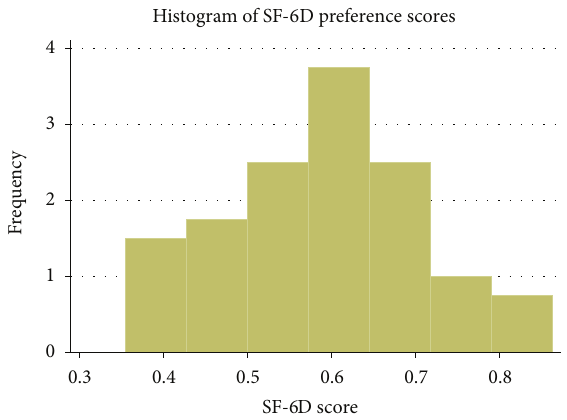
Figure 1: Histogram of SF-6D preference scores. Skewness = 0.11.